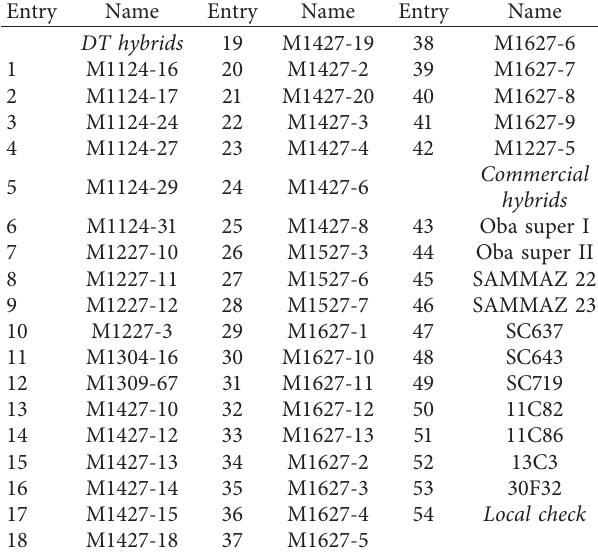
Table 1: List of three-way cross drought-tolerant maize cultivars and a local check used for assessing fodder potential in